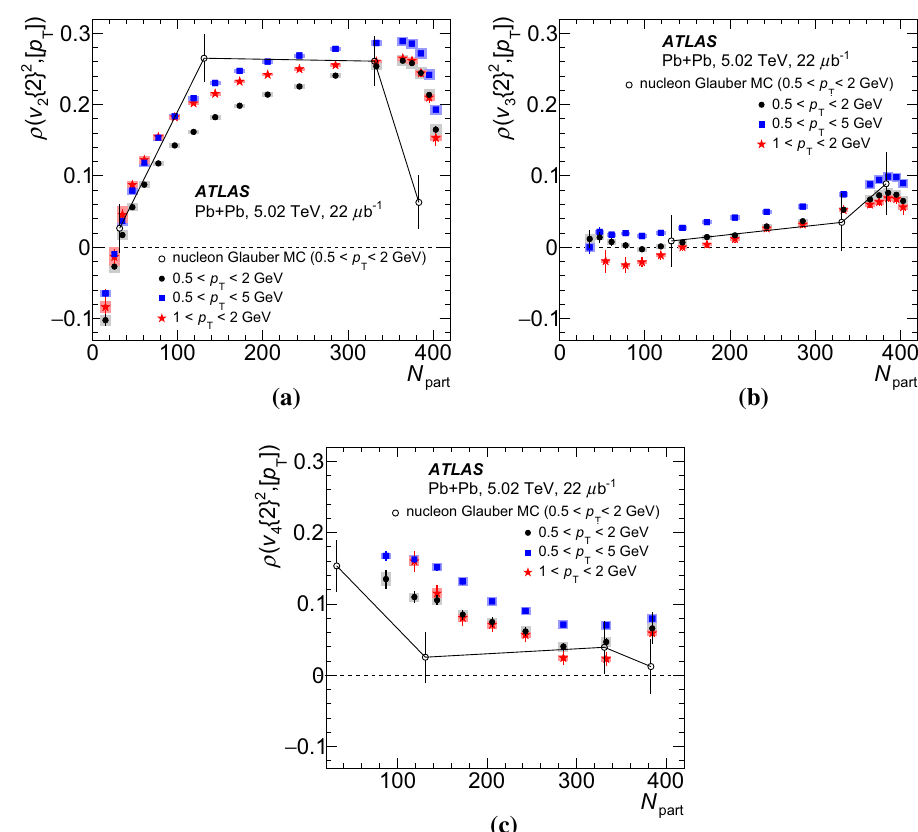
Fig. 7 The PCC ρ(v { 2 } 2 , [ p ] ) for a n = 2, b n T n = 3, and c n = 4 in Pb+Pb collisions as a function of N part for three p T ranges. The statistical and systematic uncertainties are shown as vertical error bars and boxes, respectively. A comparison with model predictions [37] is also shown with a line added to guide the